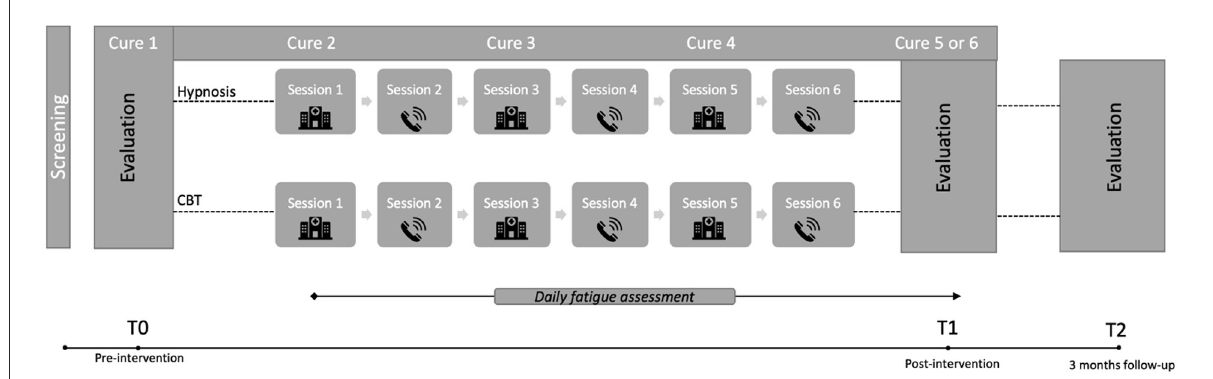
FIGURE2 Study design with two-arms randomization (hypnosis and CBT), 6 sessions each. Flexibility in terms of sessions is foreseen, i.e., a patient may have a session shifted by 1 or 2 weeks depending on its WHO performance status and/or the therapist’s availability. This takes into account the toxicities, need to always have the same practitioner for the 6 sessions, and the reality of the field (absences, vacations,